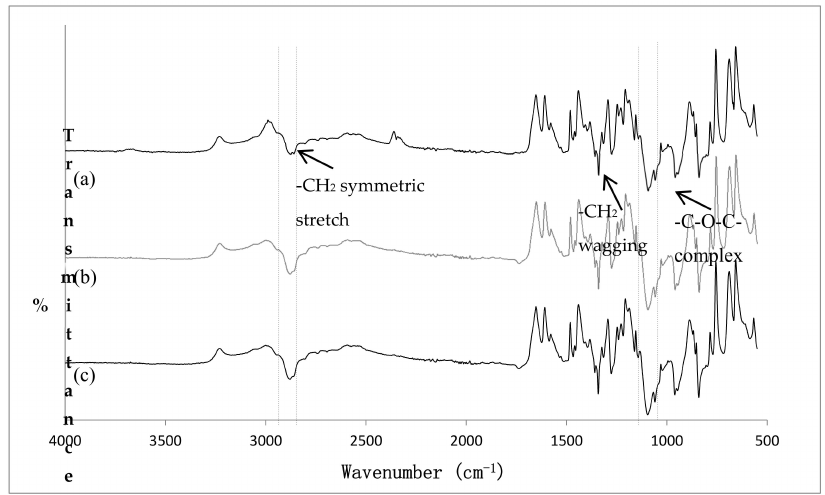
Figure 9. FT-IR spectra of ( a ) pure PEO, ( b ) unmedicated PEO xerogel film, ( c ) EtOH treated unmedicated PEO xerogel